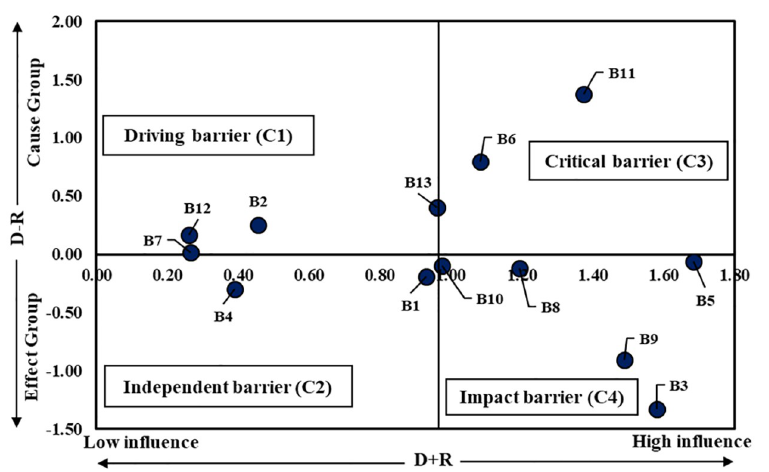
Fig 5. Representation of the cause and effect classification of